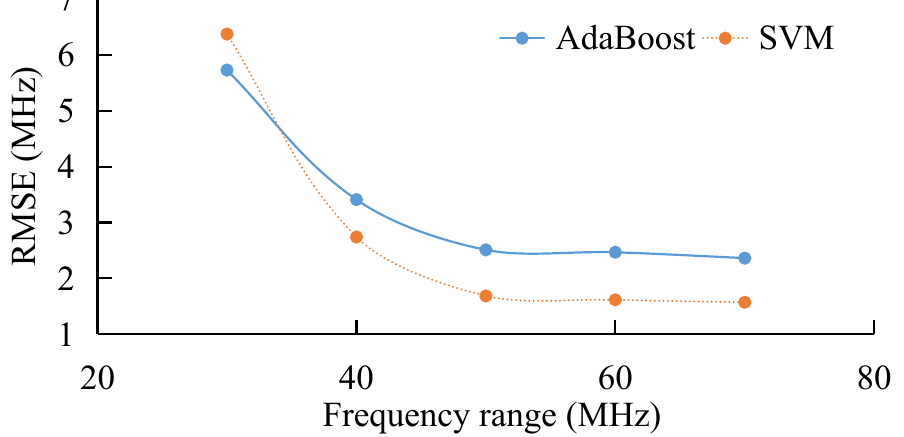
Figure 12. RMSE of the extracted BFS under different frequency range by AdaBoost and SVM.